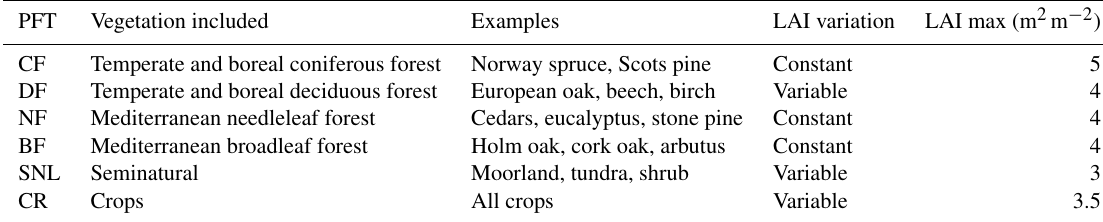
Table 3. Generic PFTs used for European emission potential maps based on EMEP.